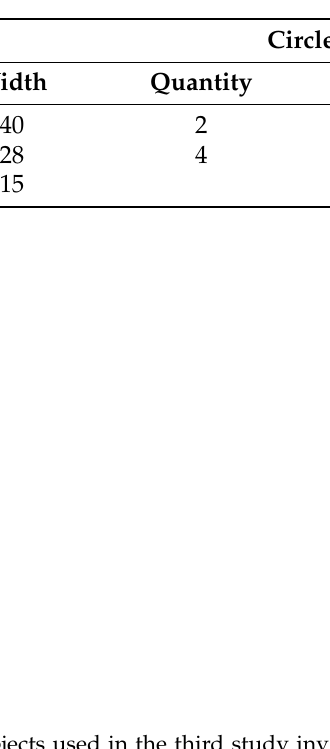
Table 5. Quantities and dimensions of the rectangular and circular objects used in the third study involving rotational degrees of freedom.